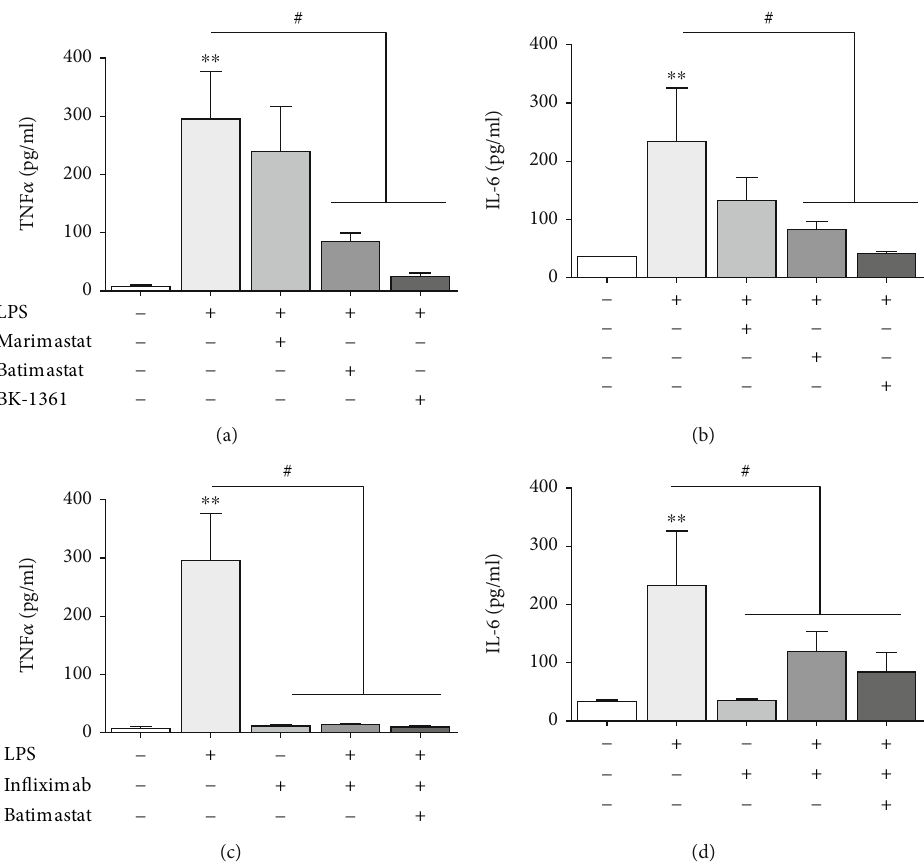
Figure 3: Reduction of LPS-induced cytokine release by inhibition of ADAM8 or TNF. (a, b) Murine Hepa1-6 hepatoma cells were left untreated or treated as indicated with LPS (1 μ g/ml) and metalloproteinase inhibitors marimastat (500nM), batimastat (500nM), and BK- 1361 (10 μ g/ml) or DMSO as control. After 24 h, supernatants were collected and analysed for the release of TNF- α and IL-6. (c, d) Hepa1-6 cells were treated as indicated with LPS, in fl iximab, batimastat, or respective controls. After 24h, supernatant was collected and analysed for the release of TNF- α and IL-6. Quantitative data are shown as the mean + SD of 3-4 independent experiments. Signi fi cant di ff erences to the unstimulated controls are indicated by asterisks ( ∗ p < 0 : 05 , ∗∗ p < 0 : 01 , and ∗∗∗ p < 0 : 001 ). Signi fi cant di ff erences caused by the inhibitors are indicated by hashtags ( # p < 0 : 05